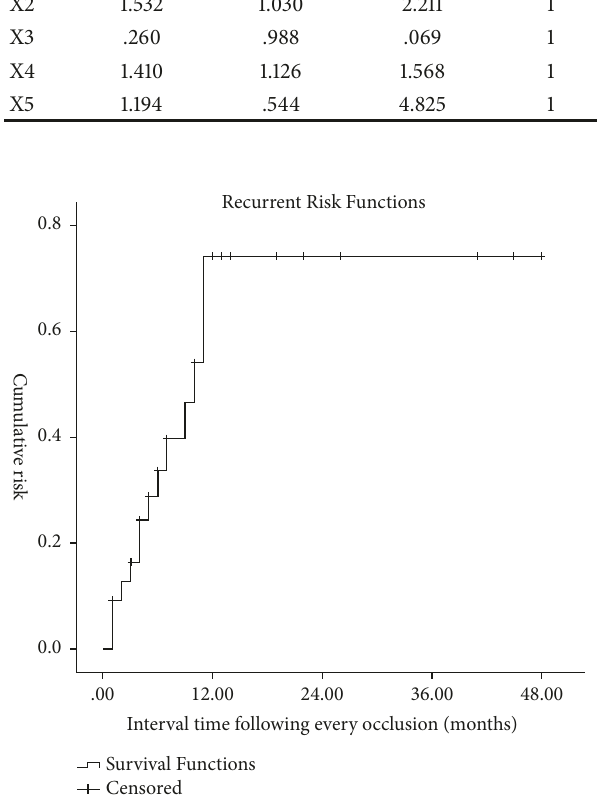
Figure 4: The curve describes the recurrence risk functions for hemoptysis after an occlusion of targeted abnormal BAs, which indicates a high risk following each procedure in the first